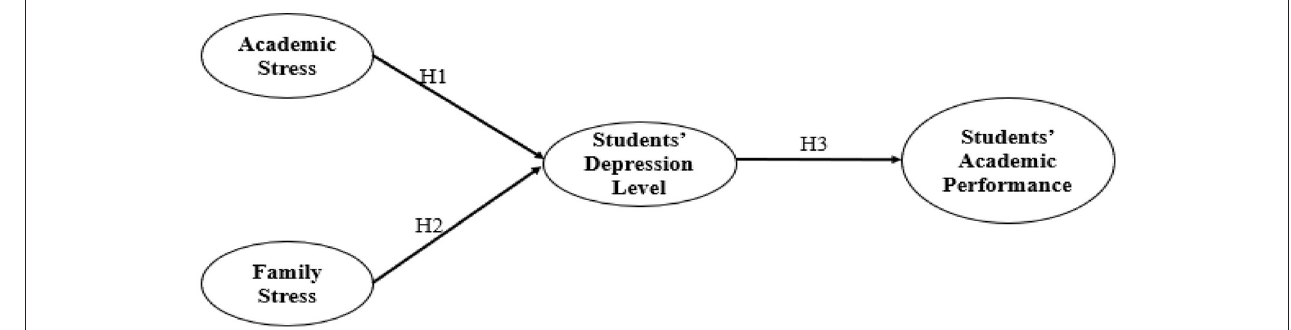
FIGURE 1 | Conceptual